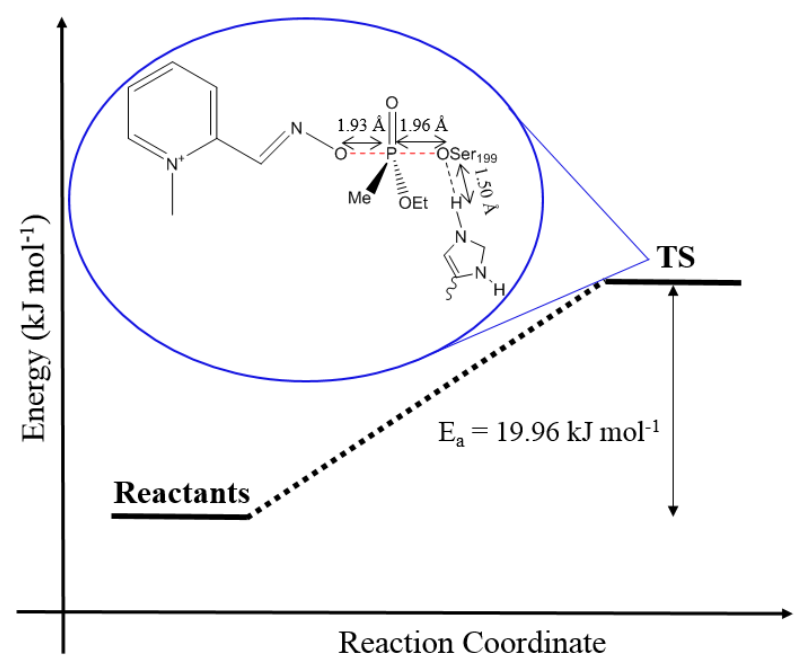
Figure 5. Activation energy profile for the formation of the complex 2-PAM/VX/Ser203.